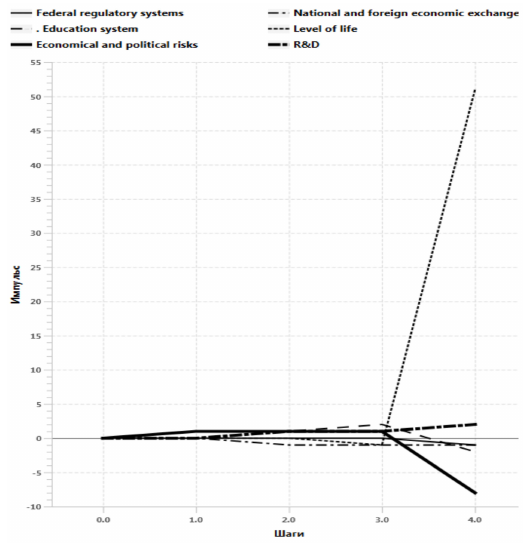
Figure 12. The graph of impulse processes at the vertices V6, V7, V10, V12, V16, V20 Scenario "Improving the conditions of higher education and economical and political risks increasing" disturbing momentum q10 = + 1 and q16 = +